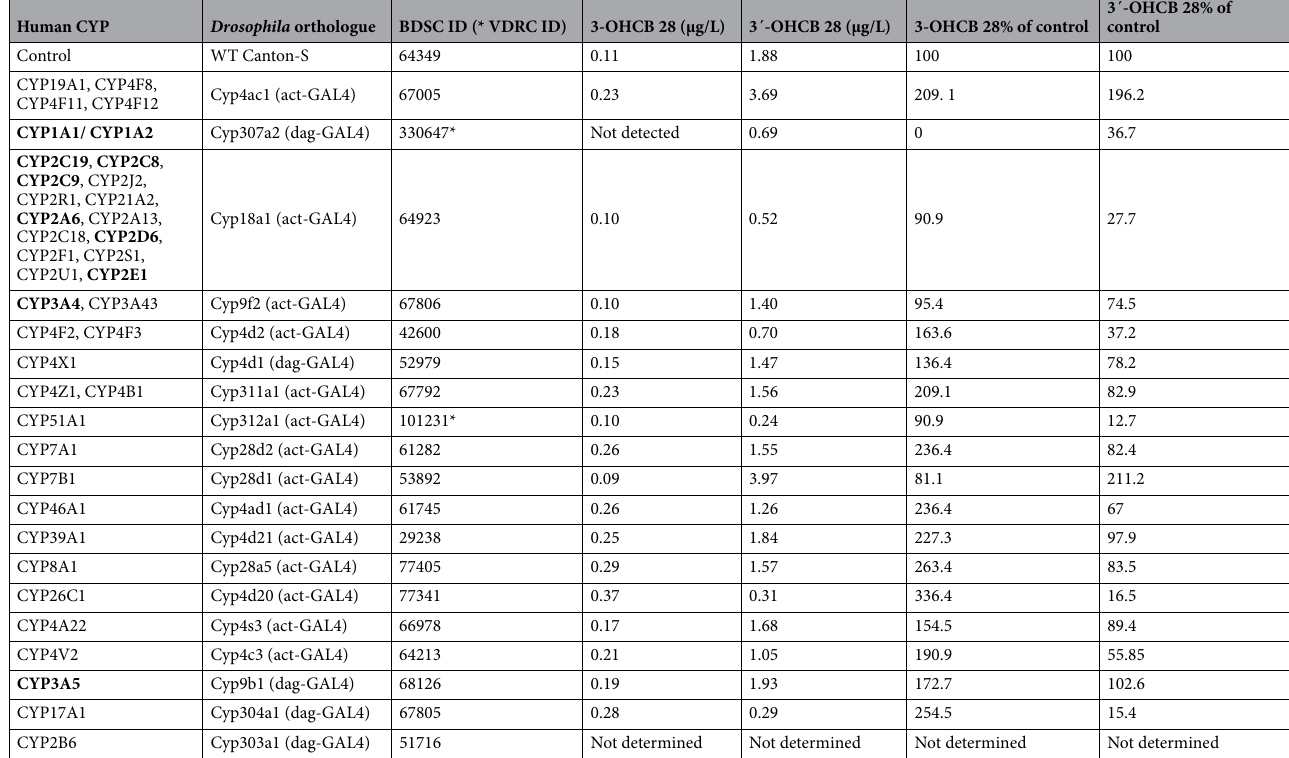
Table 1. PCB 28 metabolisation and mortality of adult Drosophila wild type (WT) and genotypes with an ubiquitous expression of dsRNA for certain CYP enzymes. Male flies of the respective RNAi strain (UAS-CYP) were paired with virgins of the ubiquitous driver strain act-GAL4 or dag-GAL4as indicated. For metabolism screening, F1 generations were fed with PCB 28 at low (20 µM) concentrations. After 48 h of incubation